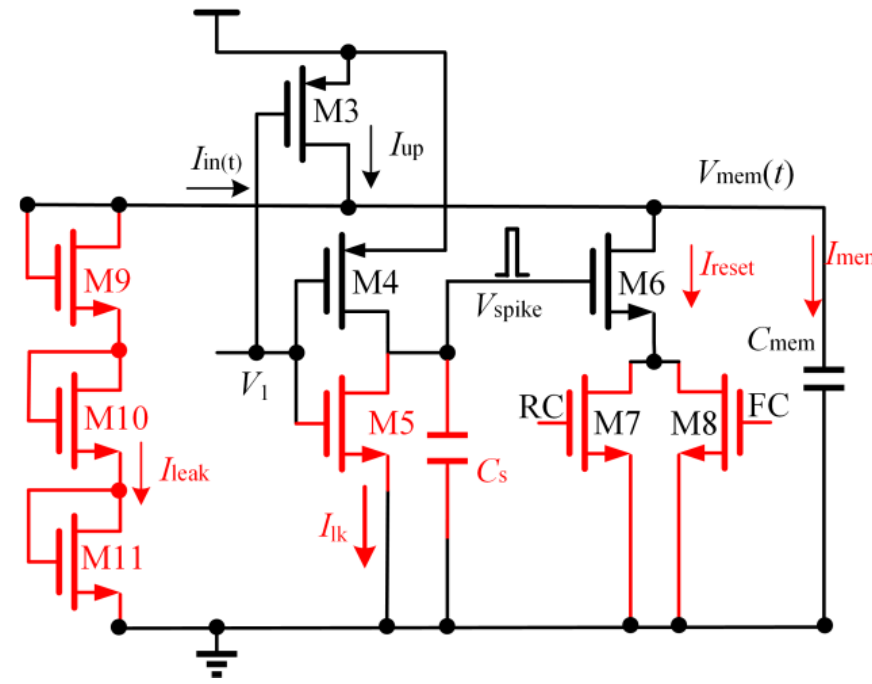
Figure 10. Injection current analysis of neuron after irradiation.